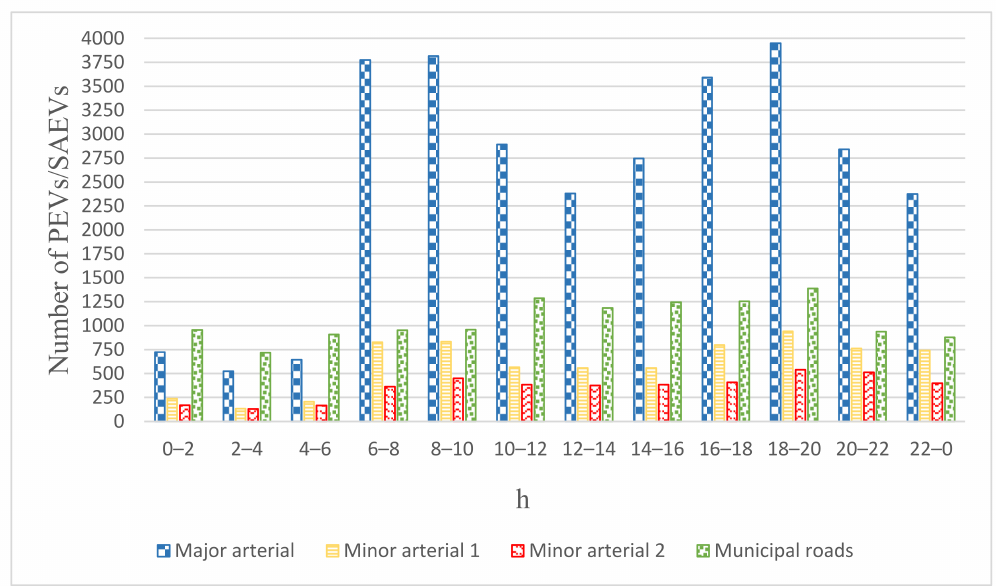
Figure 5. Traffic volumes of all road sections after rideshare companies support ridesharing service.